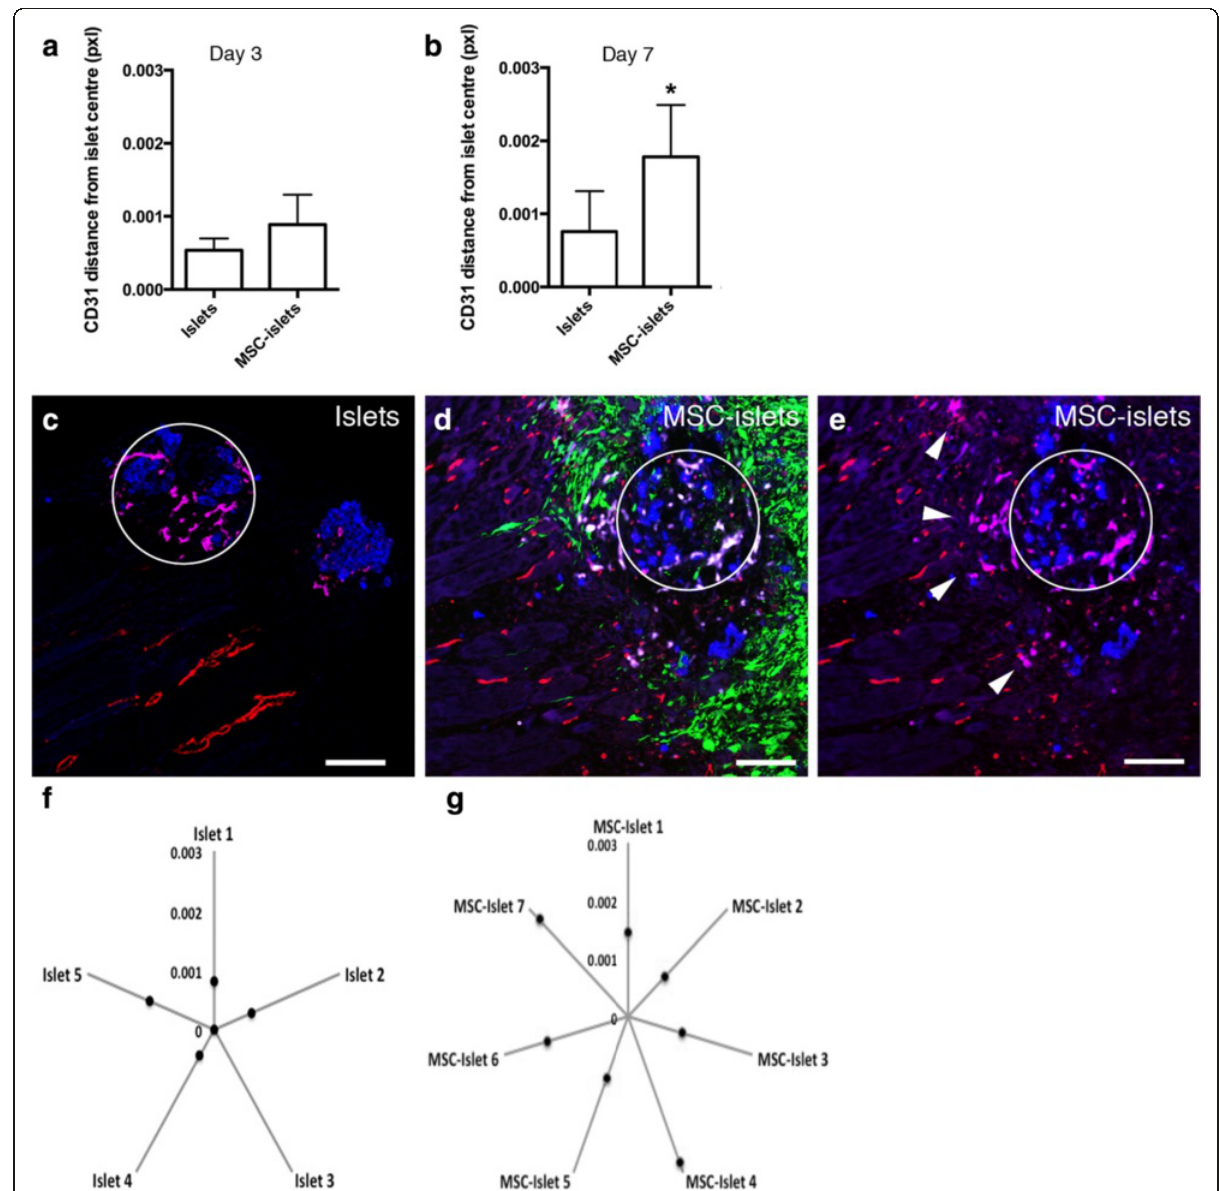
Fig. 6 Facilitated islet endothelial cell migration out into the surrounding tissue in the presence of MSC. a Mean distance of human CD31 expressing vessels from the center of the islet in control islets and MSC-islets at three days post transplantation ( n = 4). b Mean distance of human CD31 expressing vessels from the center of the islet in control islets compared to MSC-islets at seven days post transplantation (* p < 0.05, islets n = 5, MSC-islets n = 7) using a Mann – Whitney test. c In control sections after one week, the human islet endothelial cells (purple) remained inside the islet graft (blue, centrally marked by a white circle) avoiding direct contact with the recipient vasculature (red). d In the MSC-islets (green and blue, respectively, centrally marked by a white circle) the presence of human islet endothelial cells (white/purple) were more prominent at distance of the islet graft at the same time point. e Same figure as in panel D excluding the MSC signal in green showing the human islet endothe- lial cells (purple, marked with white arrow heads) migrating out to the surrounding tissue (day 7). f Mean distance of human endothelial cell migration from the center of the control islet grafts in each study object 7 days post transplantation ( n =5). g Mean distance of human endothelial cell migration from the center of the MSC-islet grafts in each study object 7 days post transplantation ( n =7). Bars =100